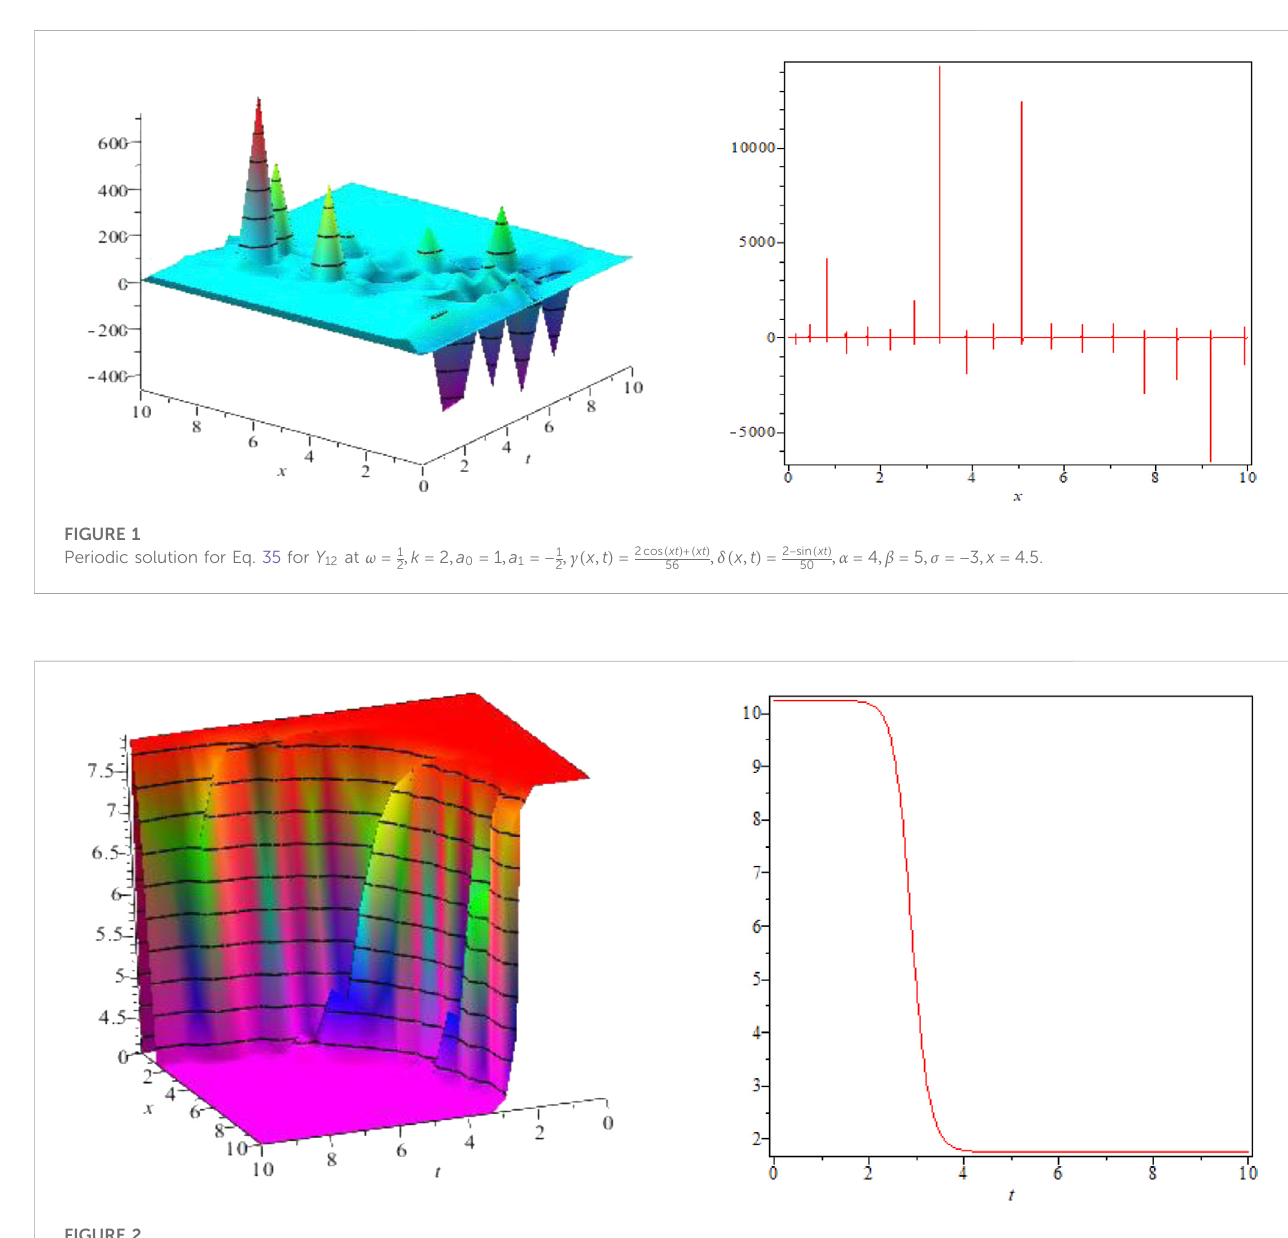
FIGURE 2 Kink-shaped solution for Eq. 35 for Y 5 at ω (cid:2) 2 , k (cid:2) 3 , a 0 (cid:2) 5 , a 1 (cid:2) 5 , γ ( x , t ) (cid:2) 2cos ( xt )+( xt )